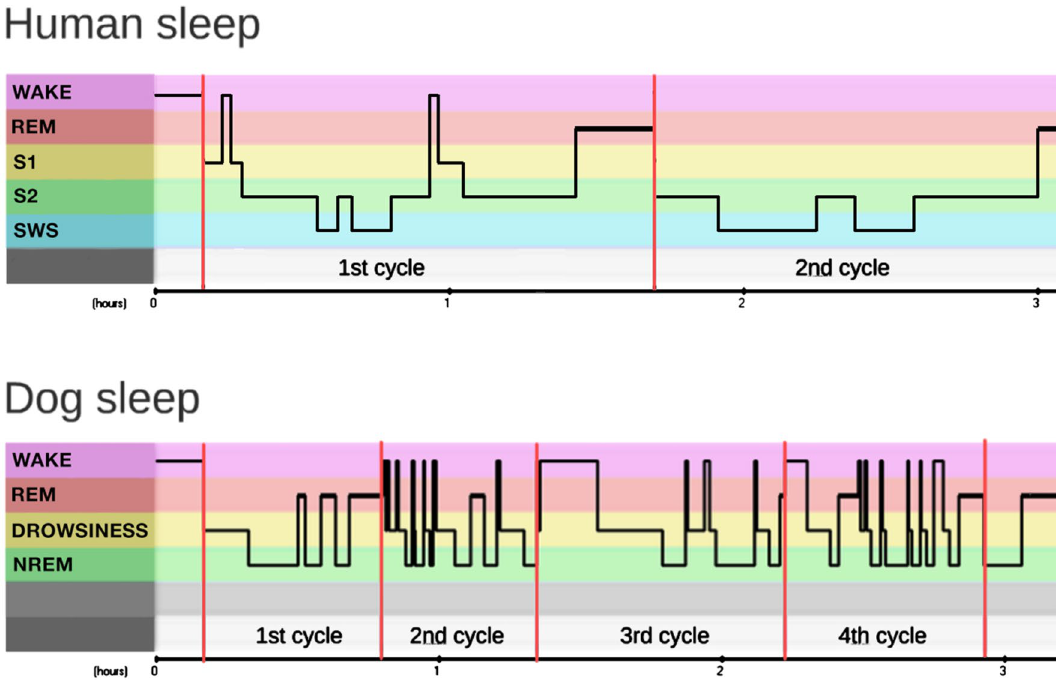
Figure 2. Typical hypnogram of three-hour-long sleep recordings of a human and a dog. In dogs due to the great number of awakenings and short REM sleeps compared to humans, we defined a dog’s sleep cycle differently. Our criteria were that (1) a sleep cycle should contain at least 6 min of NREM sleep, (2) if a wake period contained more than 5 min wake time, the subsequent sleep period was defined as the beginning of the next sleep cycle, (3) if a sleep cycle ended with a REM phase longer than 3 min and an awakening (of any length) followed, the subsequent sleep period was also defined as the next sleep cycle. We provided descriptive data of sleep macrostructure (mean ± SD durations of drowsiness, NREM and REM sleep) of each sleep cycle in sleep recording 1 and 2 (see our Supplementary document, Table